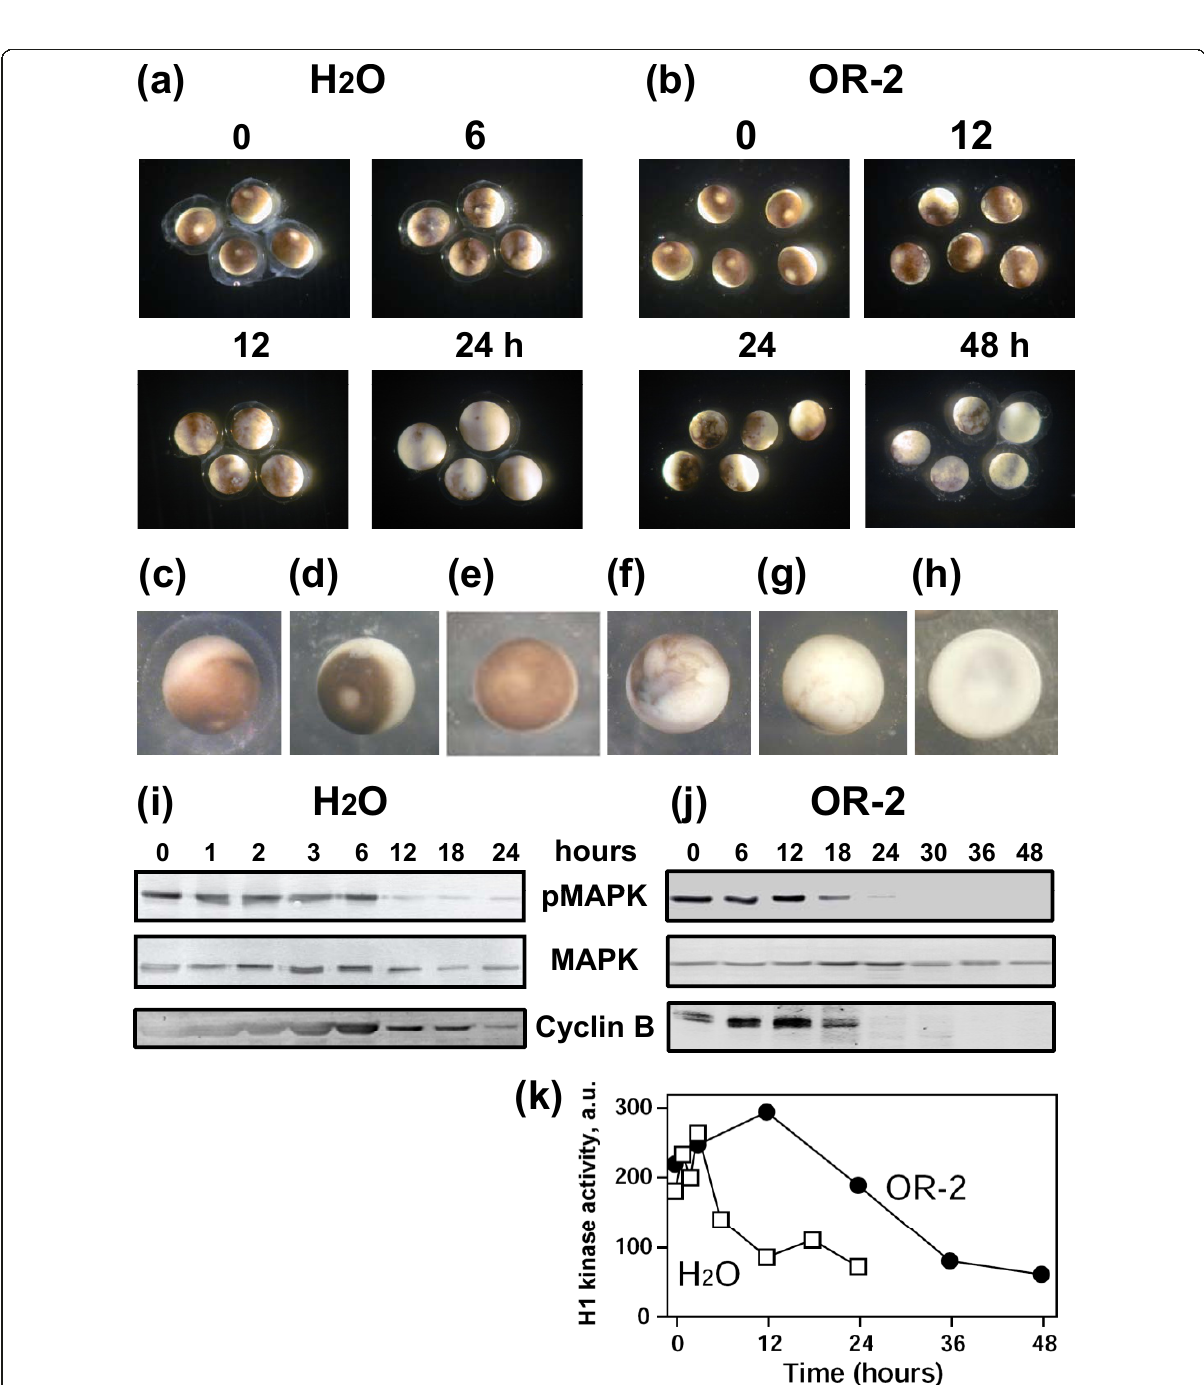
Figure 1 Spontaneous meiotic exit in unfertilized Xenopus eggs . Changes in the morphology of water-deposited (a) and OR-2 buffer- deposited (b) eggs, major morphological types of the unfertilized eggs (c-h) , MAPK dephosphorylation and cyclin B2 degradation (i, j) , and H1 kinase activity of Cdk1 in water-deposited and buffer-deposited eggs (k) are presented. Time after egg ovulation (hours) is